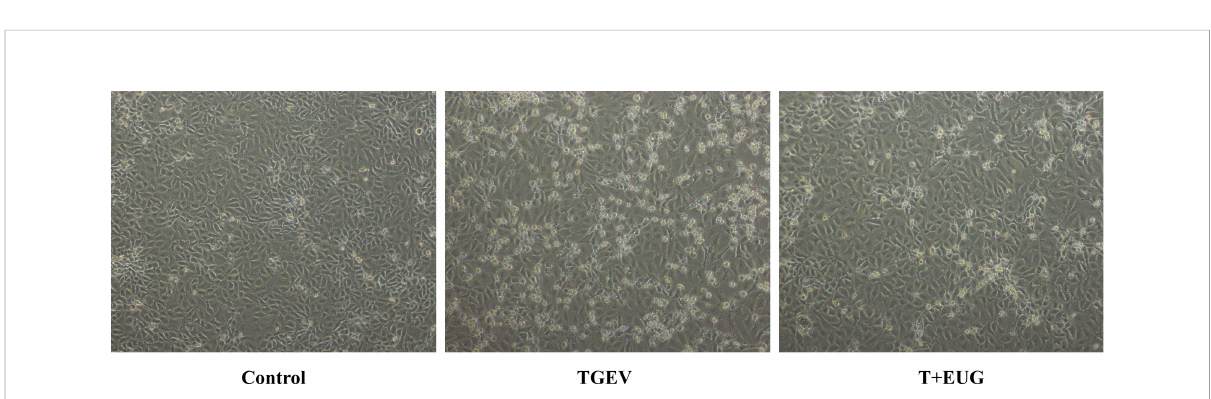
FIGURE 10 Effects of TGEV infection on the morphology of IPEC-J2 cells. Phase-contrast images of TGEV-treated IPEC-J2 cells. Scale bar, 50 m